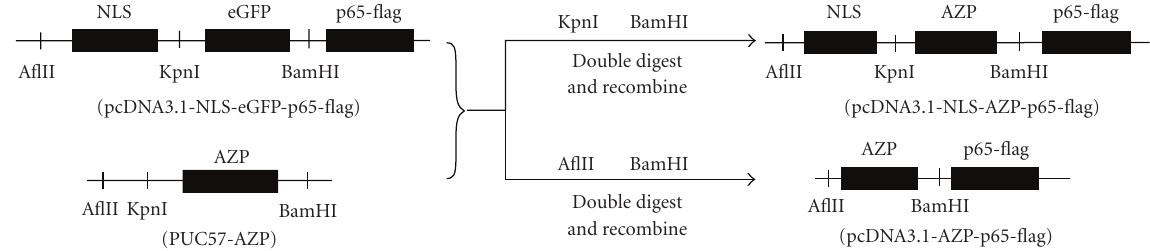
Figure 2: Construction of the ATF vectors. PUC57-AZP and pcDNA3.1-NLS-eGFP-p65-flag were double digested at the KpnI (AflII) and BamHI restriction sites respectively to obtain the AZP and pcDNA3.1-p65-flag (pcDNA3.1-NLS-p65-flag) fragments. The two fragments were then recombined to construct pcDNA3.1-NLS-AZP-p65-flag (pcDNA3.1-AZP-p65-flag) vector.